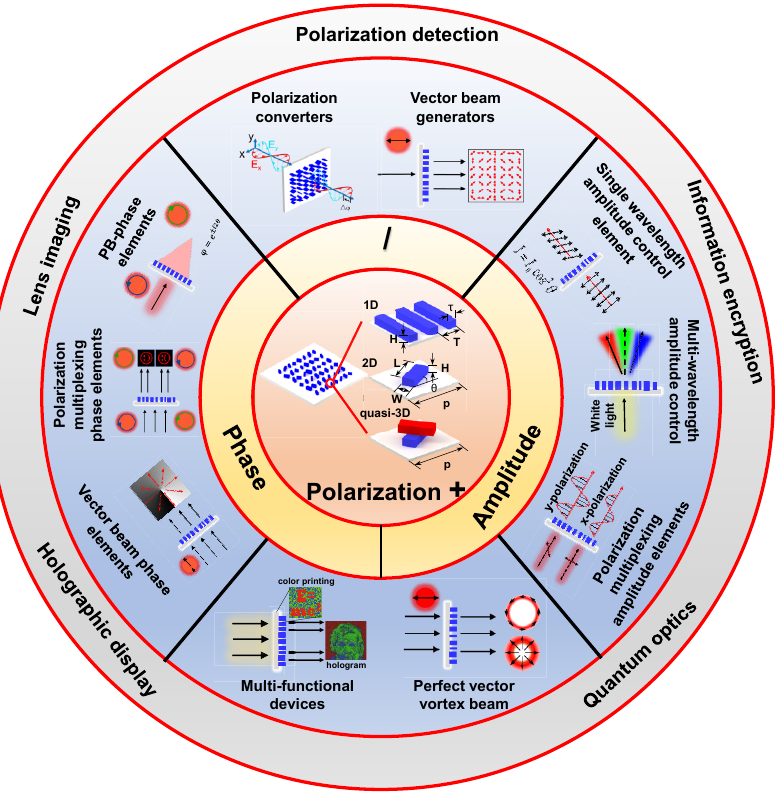
Figure 2: Framework diagram of “ polarization plus ” for achieving polarization-based functions and